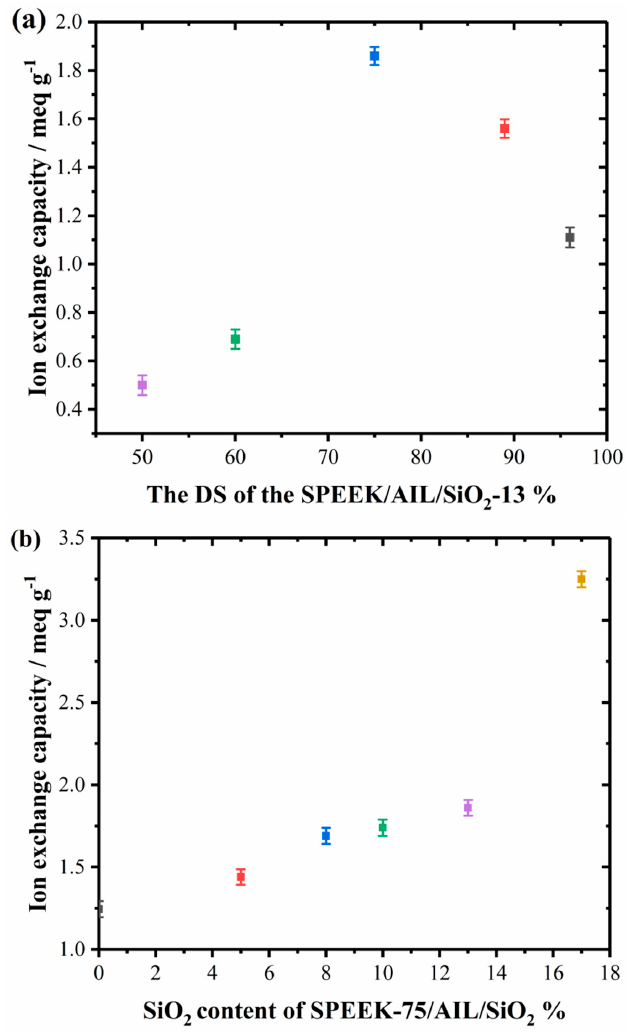
Figure 6. Ion exchange capacity (IEC) of the SPEEK/AIL/SiO 2 composite membranes with different degree of sulfonation (DS) ( a ) and SiO 2 content ( b ).